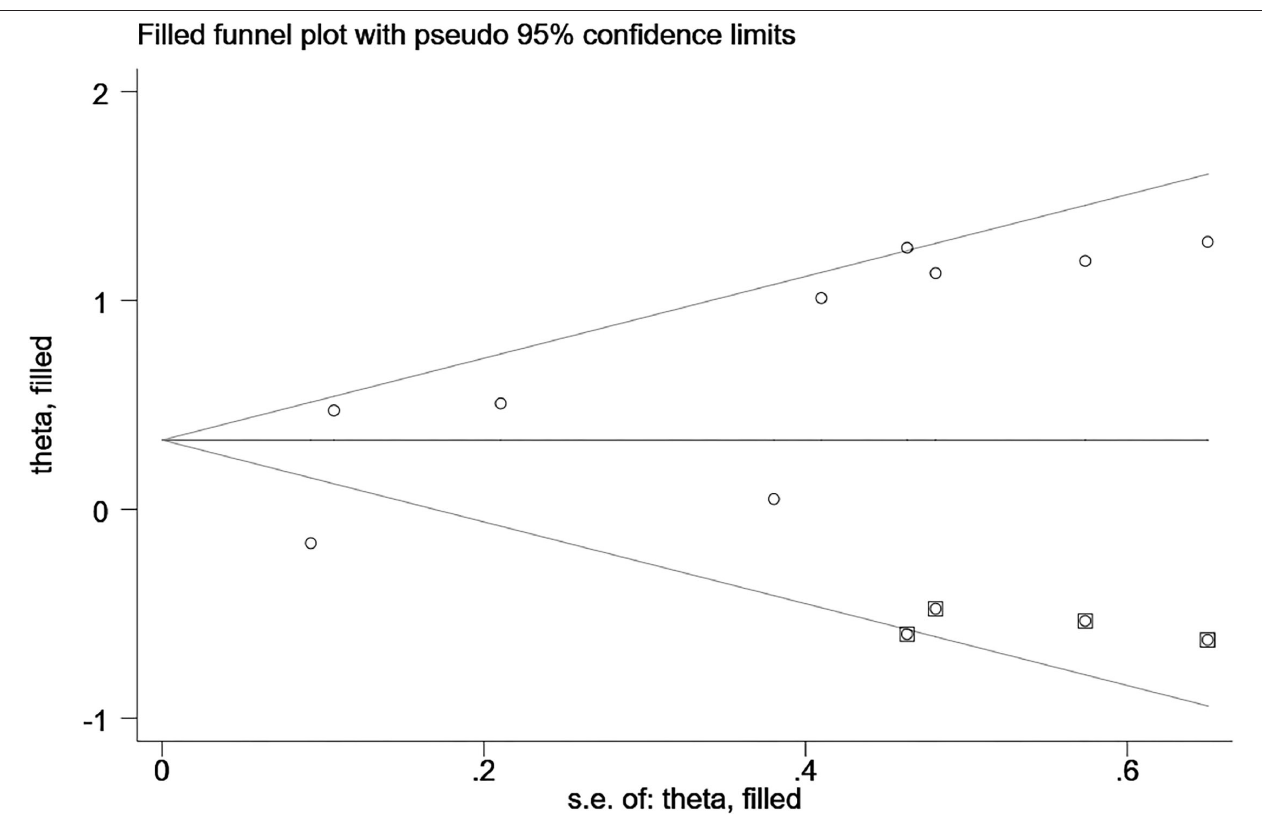
FIGURE 4 | Funnel plots with trim and fill.